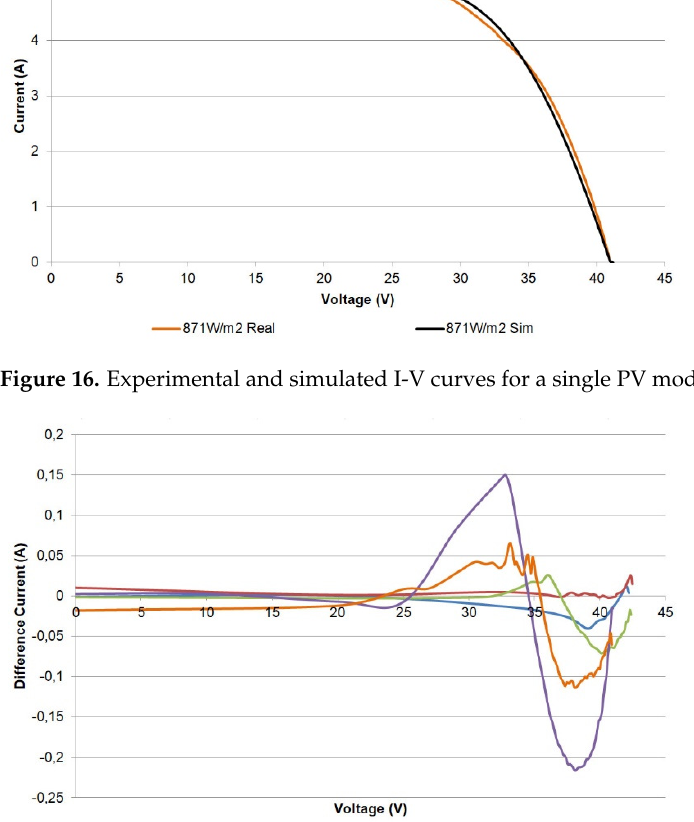
Figure 19. P ‐ V curves of a pair of PV modules. Finally, the I ‐ V curves captured for the whole PV generator are shown in Figure 20. The corresponding P ‐ V curves are depicted in Figure 21. As in the previous figures, the curves display the expected operation of the generator and can be applied for diagnostics purposes.